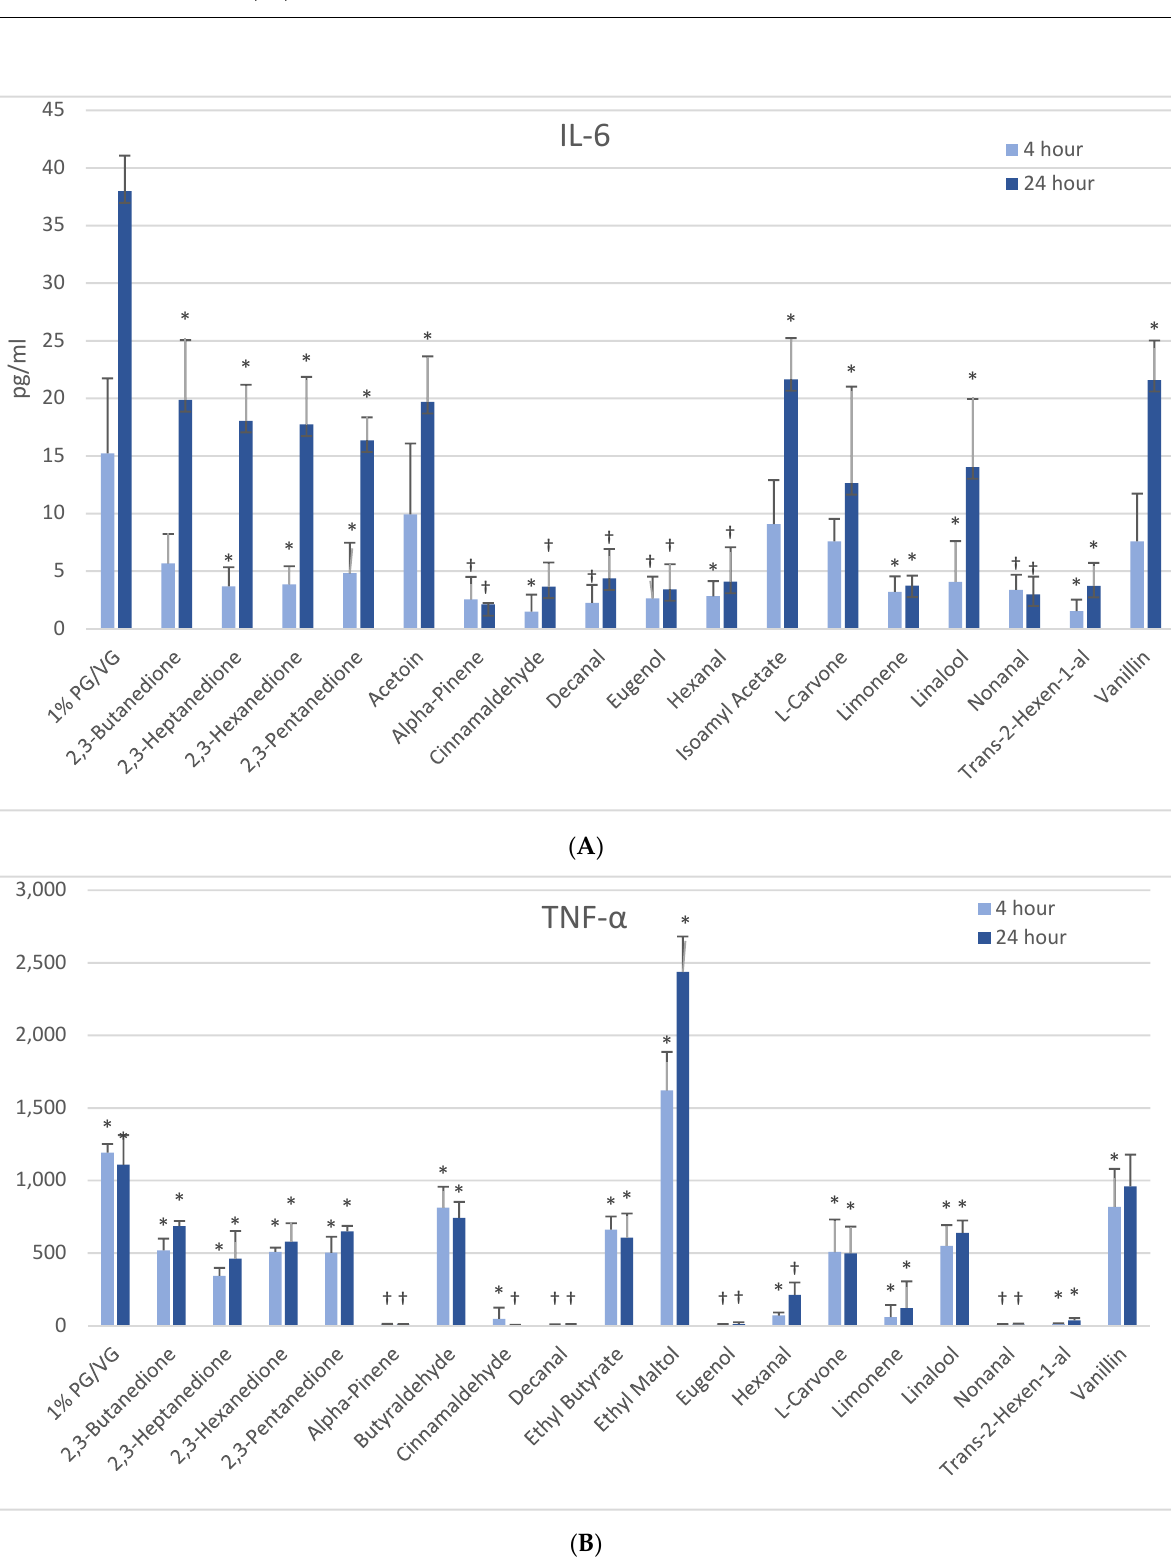
Figure 4. Cytokine production in activated THP-1 cells measured in cell supernatants after 4- and 24-h treatment with 1000 µ M of selected flavoring chemicals. ( A ) IL-6; ( B ) TNF- α . Data are presented as means ± standard error. Significance: * p < 0.05 as compared with vehicle control (1%PG/VG) and † p < 0.05 with reduced viability (Figure